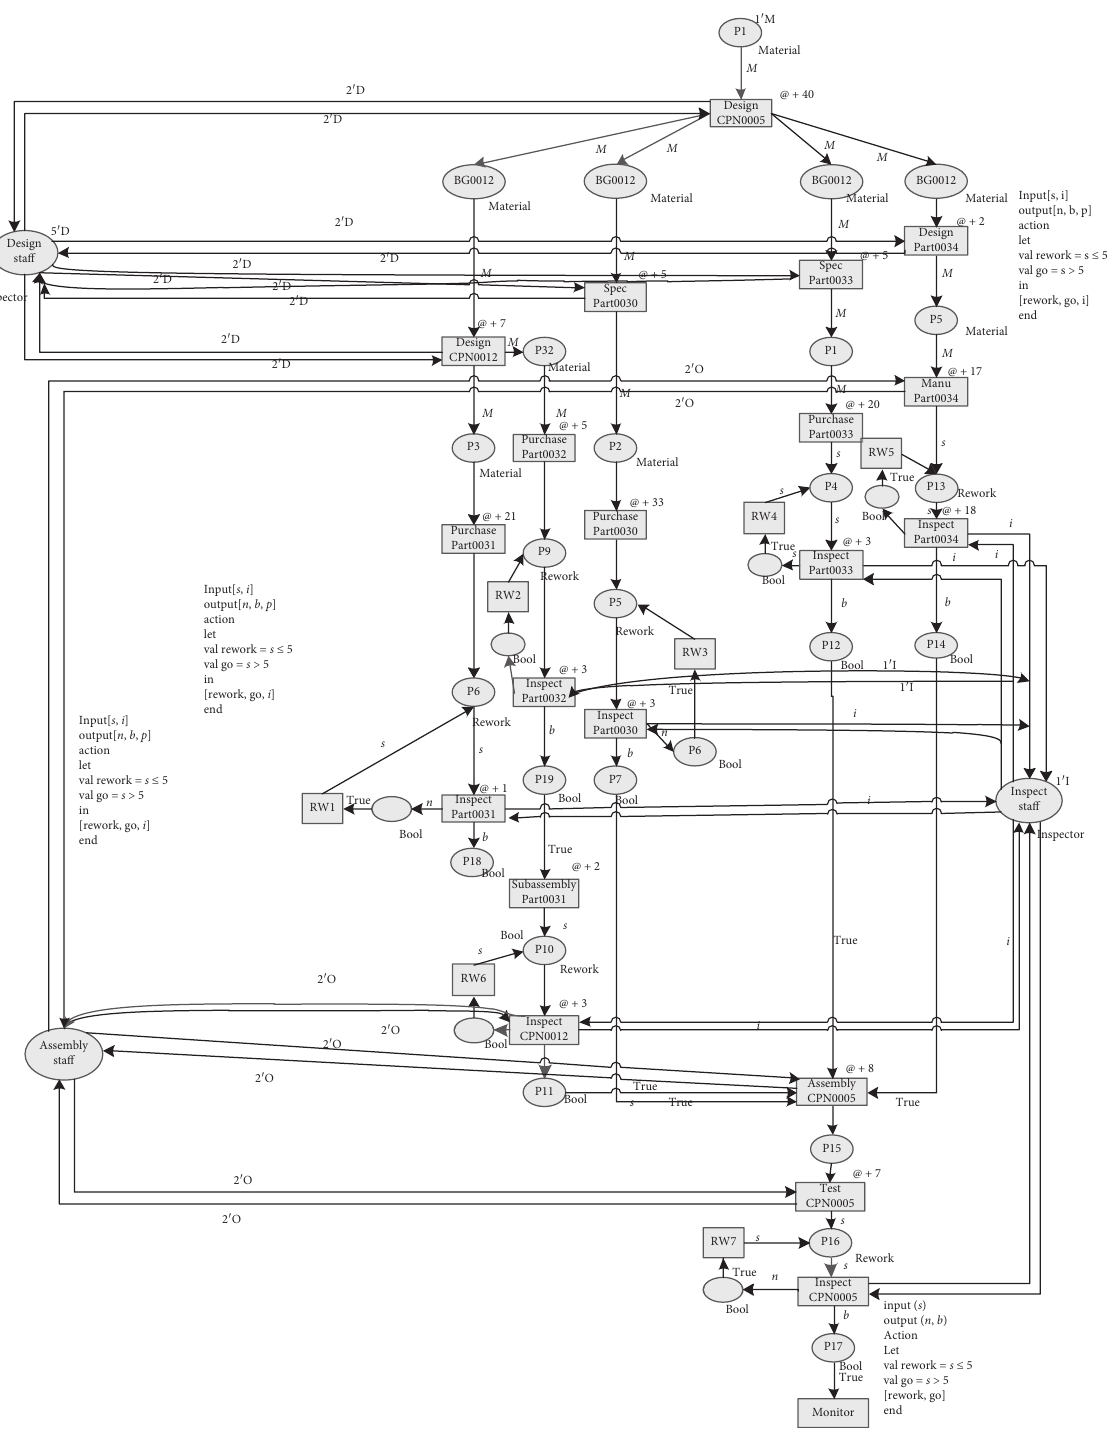
Figure 11: Original CPN